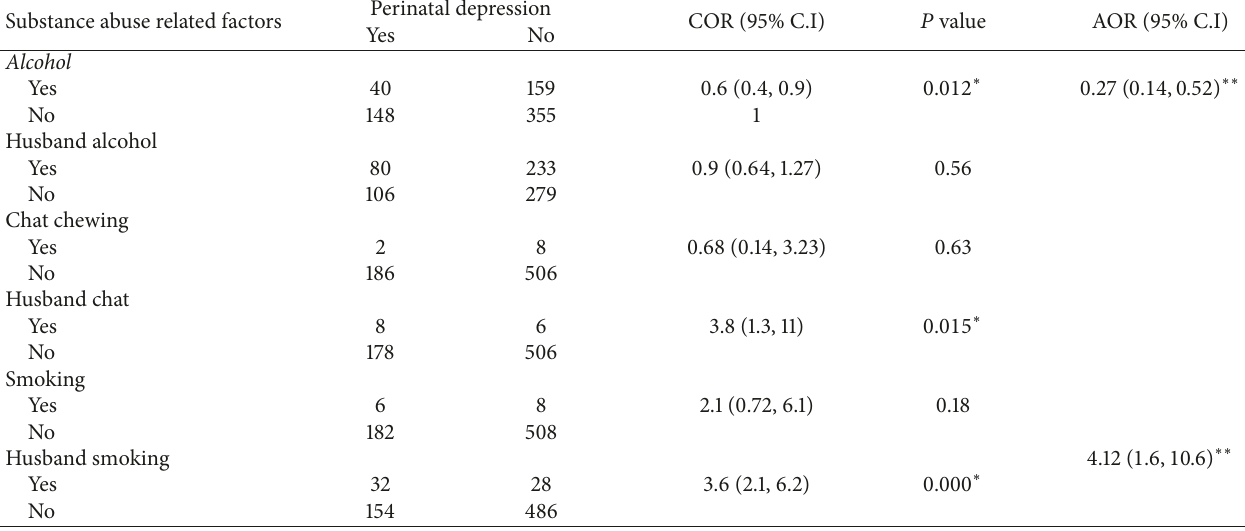
Table 5: Analysis of substance abuse related factors of participants associated with perinatal depression, Arba Minch Zuria District, Ethiopia, March, 2017.